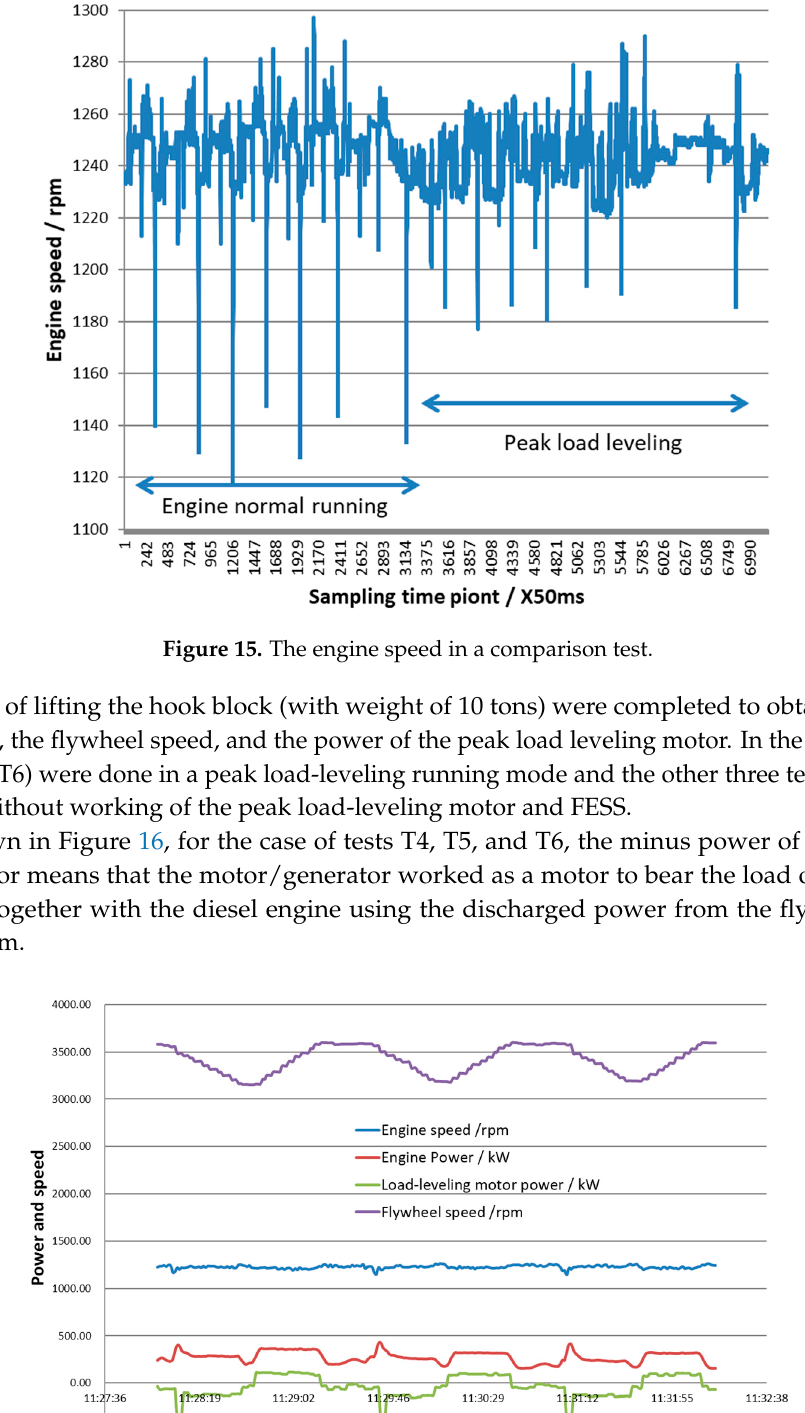
Figure 15. The engine speed in a comparison